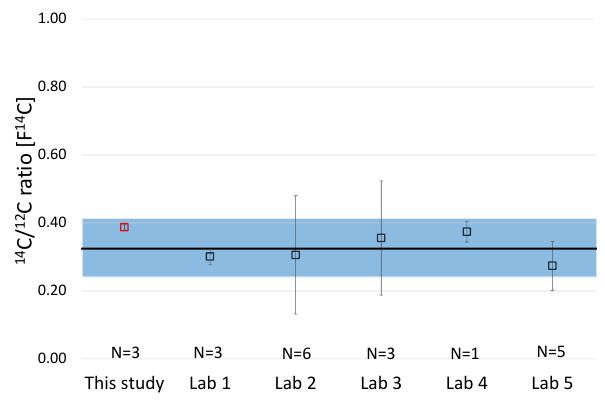
Figure 4. Location of the sampling stations in the Arve River val- ley investigated in this study. PM was sampled between Novem- ber 2013 and August 2014 in Passy and between December 2013 and January 2014 in Chamonix. Both are urban stations, collecting the PM 10 fraction of atmospheric